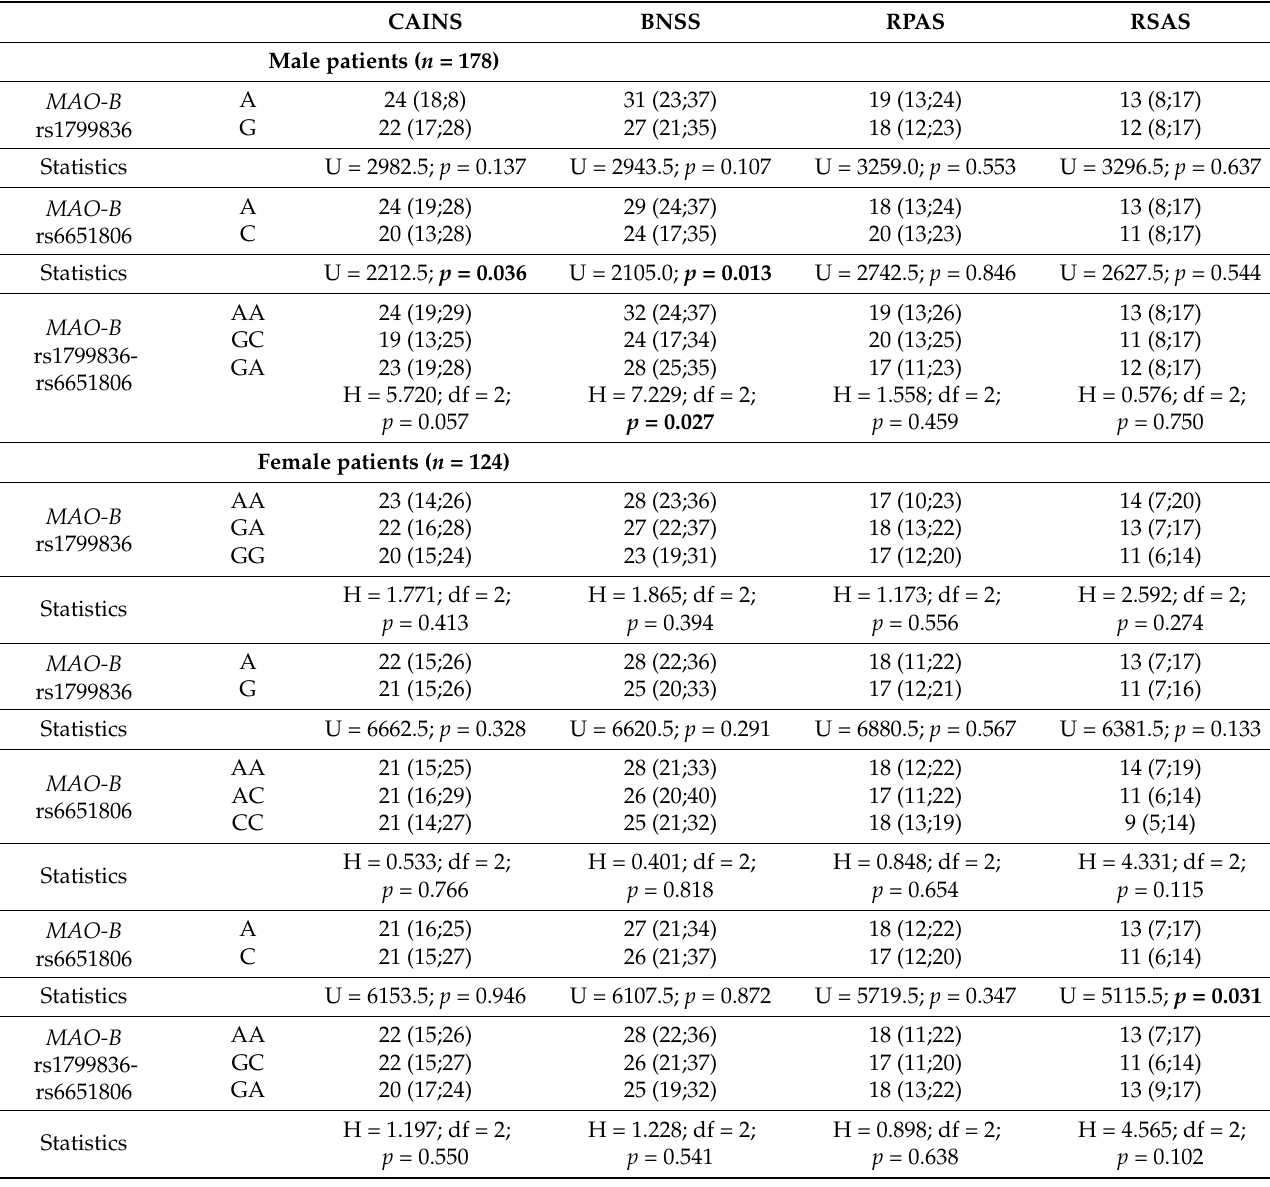
Table 4. Global functioning, severity of schizophrenia, depression, negative symptoms and physical and social anhedonia depending on MAO-B rs1799836 and MAO-B rs6651806 polymorphisms, and their haplotypes, in male and female patients with schizophrenia. The data are denoted as median and interquartile range, while p values in bold represent statistical